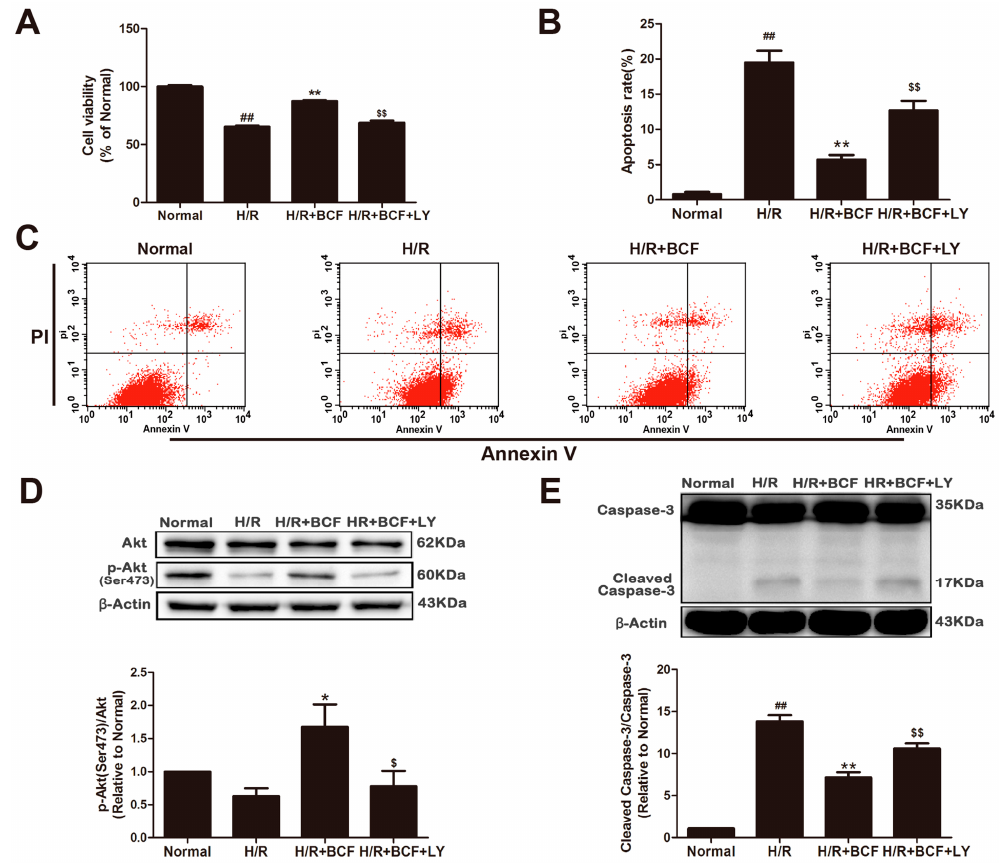
Figure 3. Blocking the PI3K/Akt pathway attenuated BCF-induced cardioprotection. H9c2 cells were pre-incubated with 20 µ M LY294002 for 1 h, and then pretreated with BCF (3.125 µ g/mL) for 4 h followed by H/R. ( A ) Cell viability was determined by CCK-8 assay; ( B ) The apoptotic ratio of H9c2 cardiomyocytes was measured by flow cytometry using Annexin V-FITC and PI staining; ( C ) The apoptosis rate was quantified by BD FACS software. Effects of BCF and the PI3K inhibitor (LY294002) on p-Akt (Ser473) ( D ); cleaved caspase-3 ( E ) and caspase-3 ( E ) expression levels in H/R-treated cardiomyocytes. β -Actin expression was examined as the protein loading control. Values were represented as mean ± SD ( n = 6, each group). ## p < 0.01 vs. normal; * p < 0.05, ** p < 0.01 vs. H/R-treated cells; $ p <0.05, $$ p < 0.01 vs. H/R + BCF-treated cells.